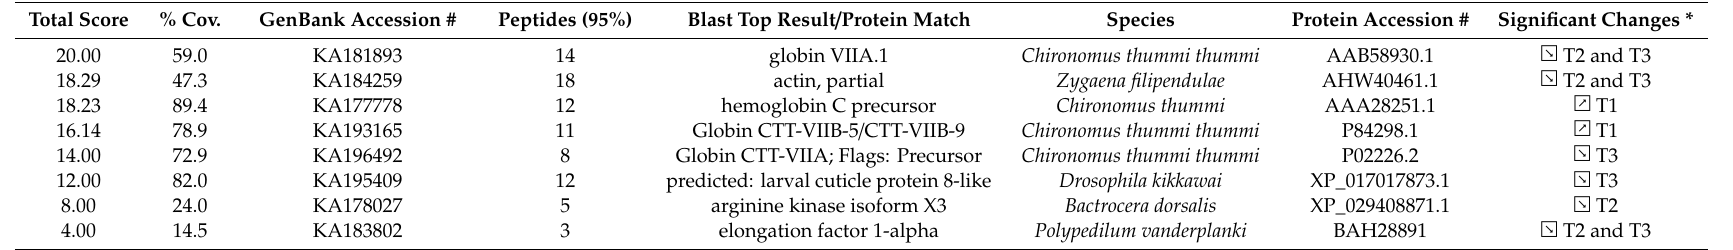
Table 2. Differentially expressed proteins in Chironomus riparius after exposure to spinosad.